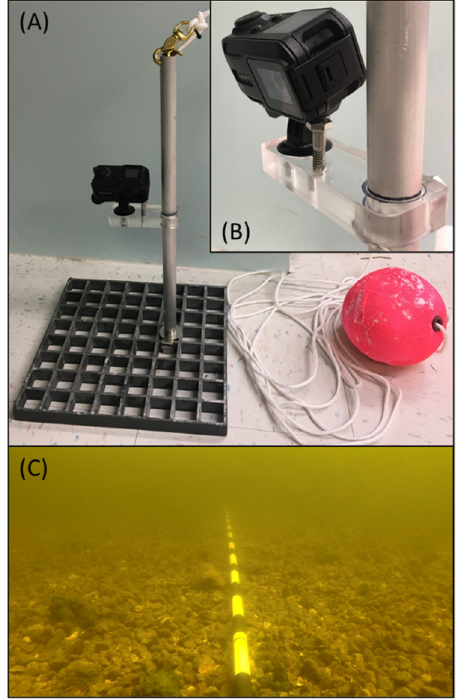
Figure 2. ( A ) Underwater video camera mounted on sampling base. ( B ) Closeup of camera mount showing fixed bolt that ensures consistent camera position between camera exchanges. ( C ) Field of view from visibility camera showing secchi pole marked at 10 cm intervals, used to estimate visibility range.